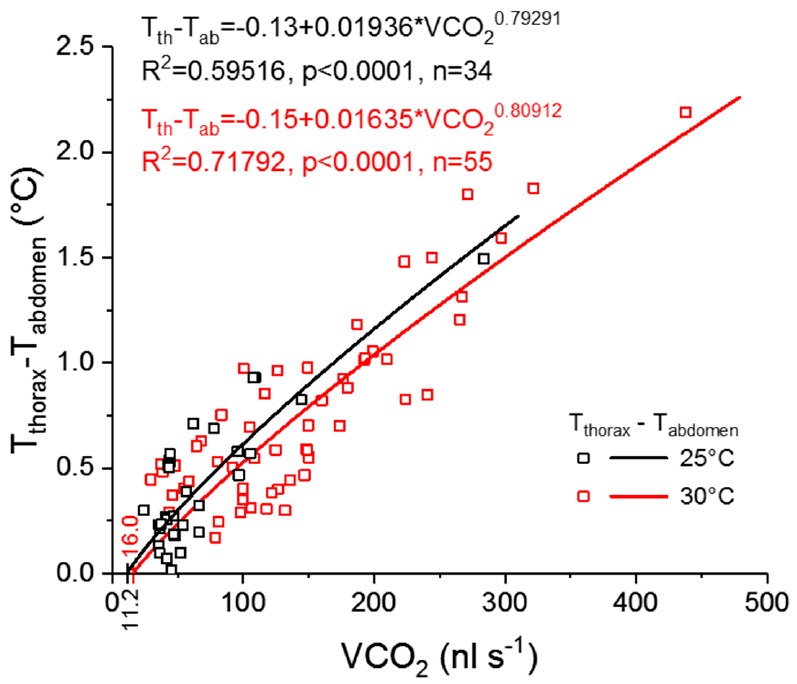
Figure 6. The correlation between the CO 2 production rate and the thorax temperature excess (T thorax – T abdomen ) of active wasps ( Polistes biglumis ) at an experimental temperature of 25 °C (black) and 30 °C (red). Indicated are the mean threshold limit values of CO 2 production rate, 11.2 nL s –1 at 25 °C and 16.0 nL s –1 at 30 °C, derived from the SMR curve-fitting (Figure 4). At these values, the thorax temperature excess is assumed to be (close to) zero.